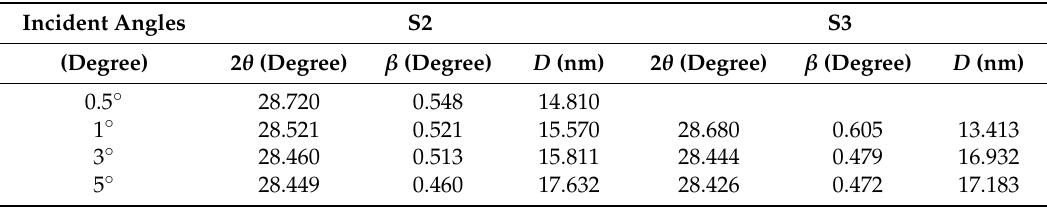
Figure 7. The m( − 111) peak of monoclinic phase of S2 and S3 in GIXRD patterns. Table 4. Peak position (2 θ (degree)), FWHM ( β (degree)), and crystallite size ( D (nm)). The average errors estimations are 0.004°, 0.007°, and 0.008 nm, respectively.